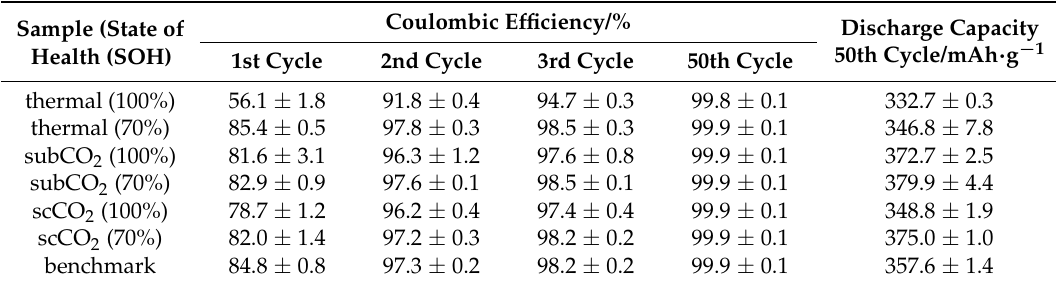
Table 2. Overview of the discharge capacities and associated Coulombic efficiencies obtained from electrochemical charge/discharge cycling experiments. SubCO 2 : subcritical carbon dioxide. It was reprinted with permission from reference [127], Copyright John Wiley & Sons,